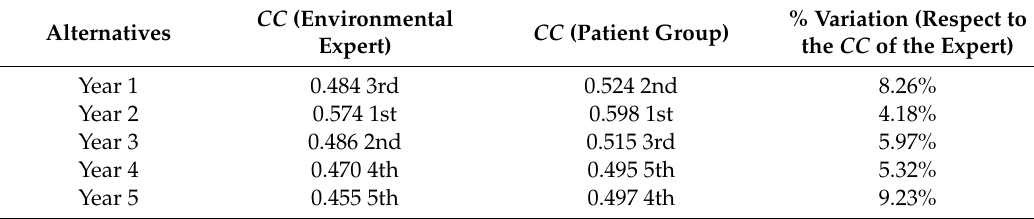
Table 9. Closeness coe ffi cient with the environmental expert and patient group judgements from each year studied.